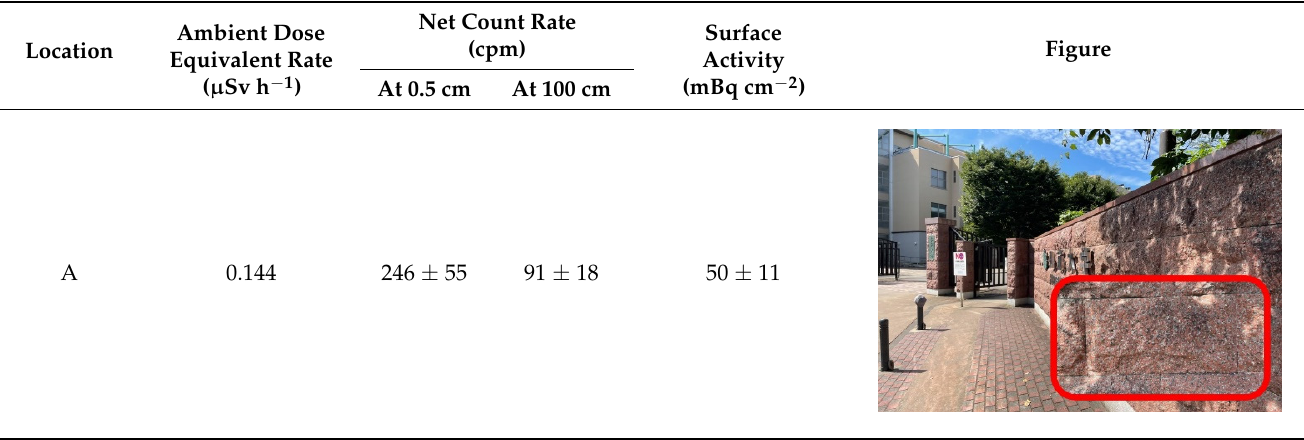
Table 1. Hotspot locations with radioactive data of building materials nearby.